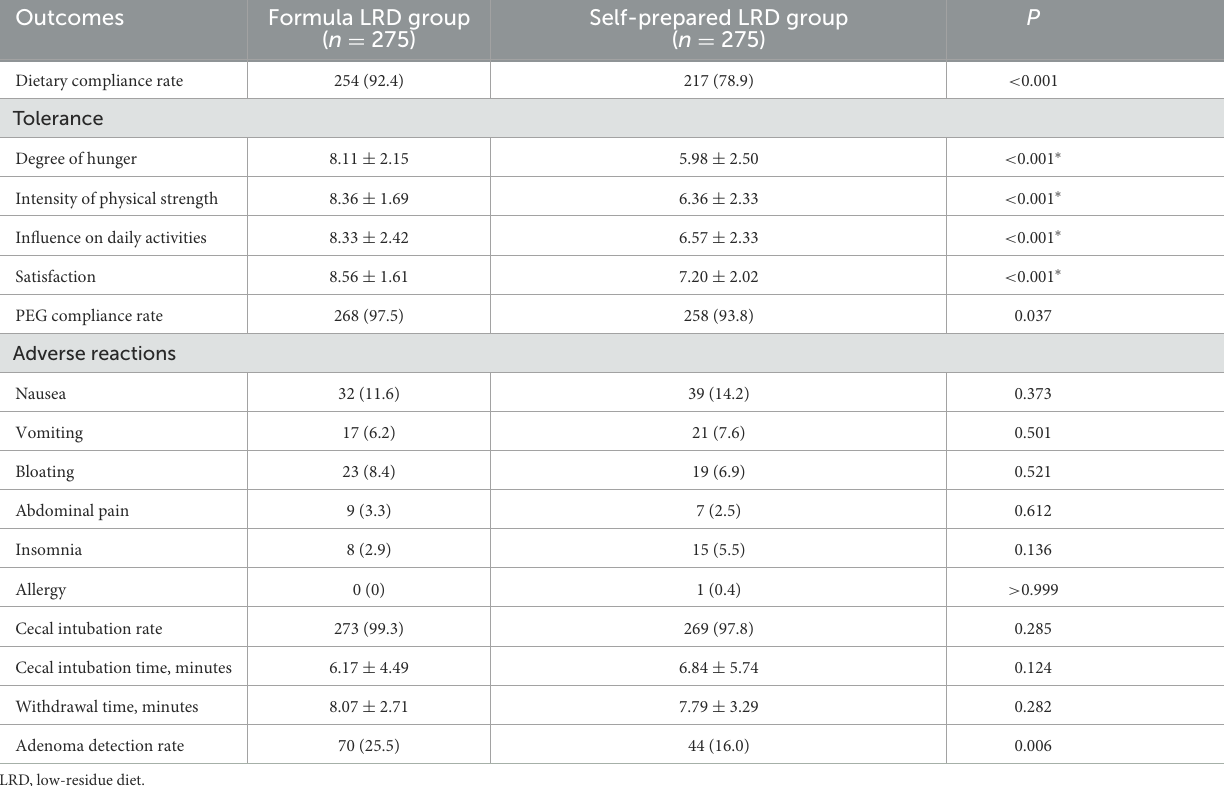
TABLE 3 Comparison of secondary outcomes by ITT analysis.